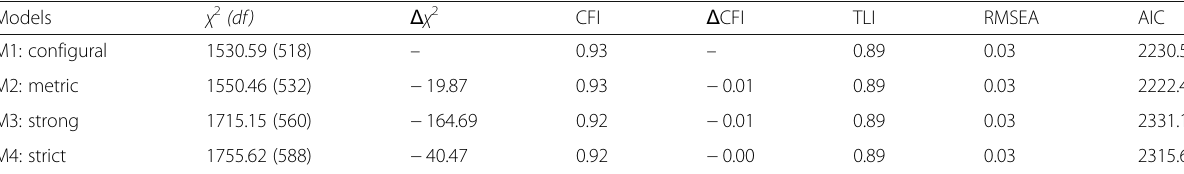
Table 4 Factorial invariance models between women ( n = 1115) and men ( n = 732)